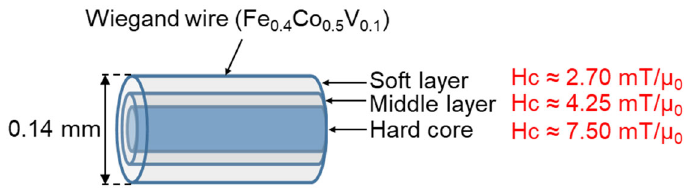
Figure 9. Magnetic structure diagram of 0.18 mm-diameter Wiegand wire.